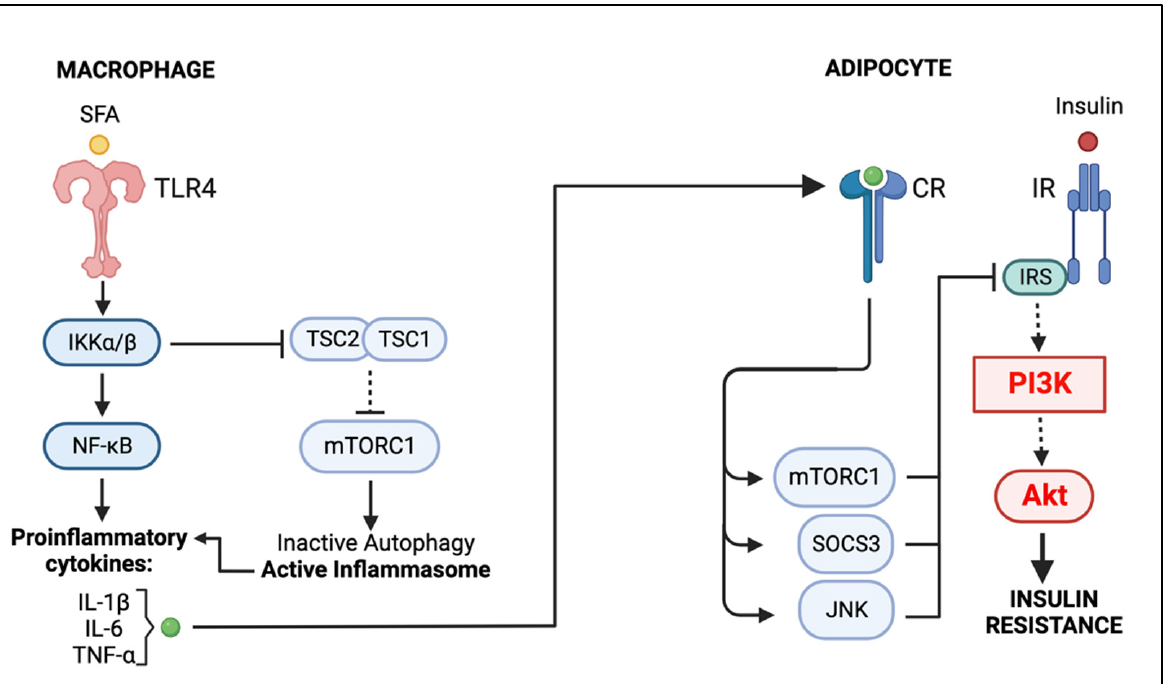
Figure 4. Graphical Summary: Macrophage–Adipocyte Crosstalk in Obese Adipose Tissue. SFAs promote the activation of macrophage NF- κ B, which, along with the active inflammasome, induces the secretion of proinflammatory cytokines. These cytokines disrupt adipocyte insulin signaling by inhibiting the IRS1-PI3K/AKT pathway. (Created with BioRender.com on 20 November 2022) Abbreviations: SFAs, saturated fatty acids; TLR4, Toll-like receptor 4; IKK, I κ B kinase; I κ B, inhibitor κ B kinase; NF- κ B, Nuclear factor kappa-light-chain-enhancer of activated B cells; TSC1/2, tuberous sclerosis protein complex 1 and 2; mTORC1, mammalian target of rapamycin complex; IR, insulin receptor; IRS, Insulin receptor substrate; PI3K, phosphoinositide 3-kinase; JNK, Jun N-terminal kinase; SOCS3, suppressor of cytokine signaling 3; IL-1 β , interleukin 1 β ; IL-6, interleukin 6; TNF- α , tumor necrosis factor α ; CR, cytokine receptor.